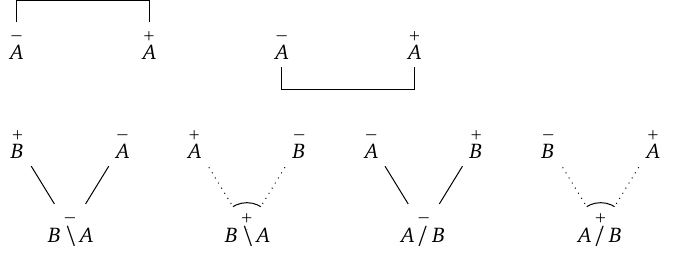
Links for Lambek calculus proof